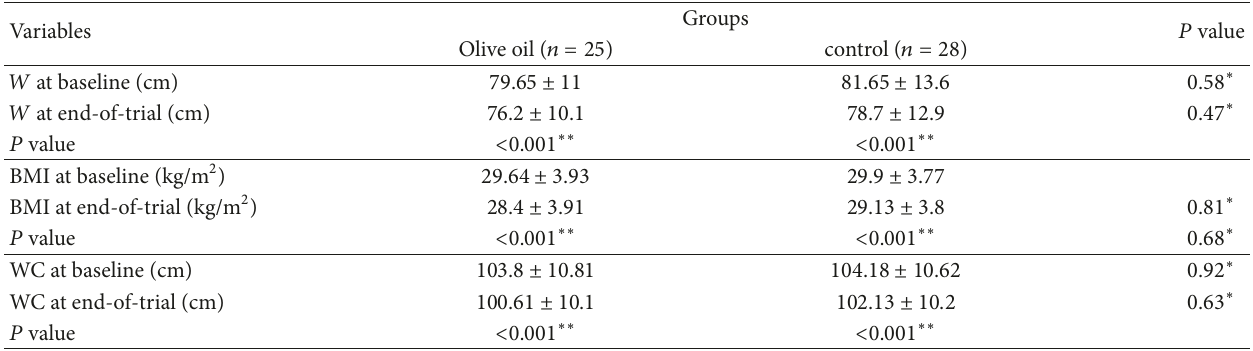
Table 2: Anthropometric measurements at baseline and the end of